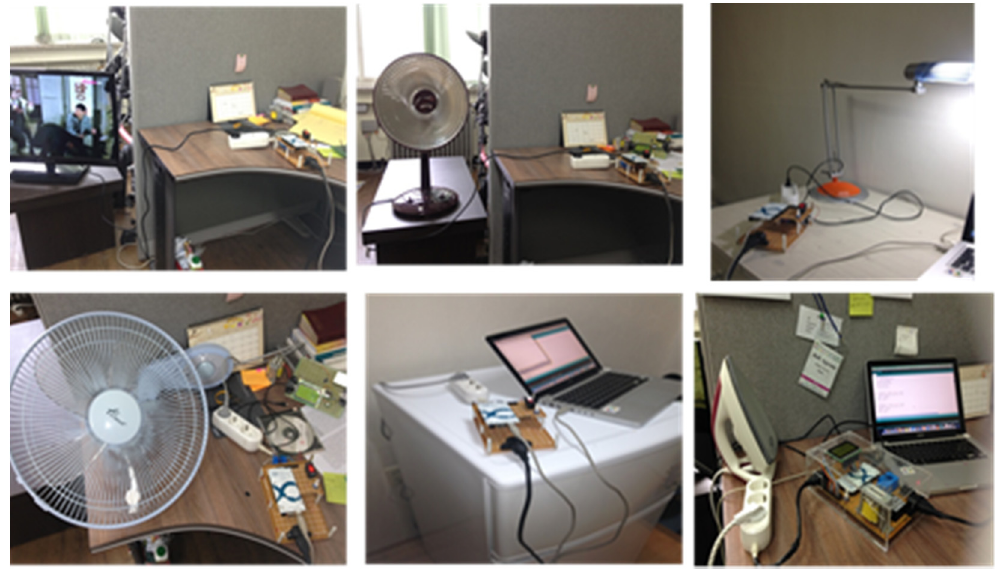
Figure 7. Appliance